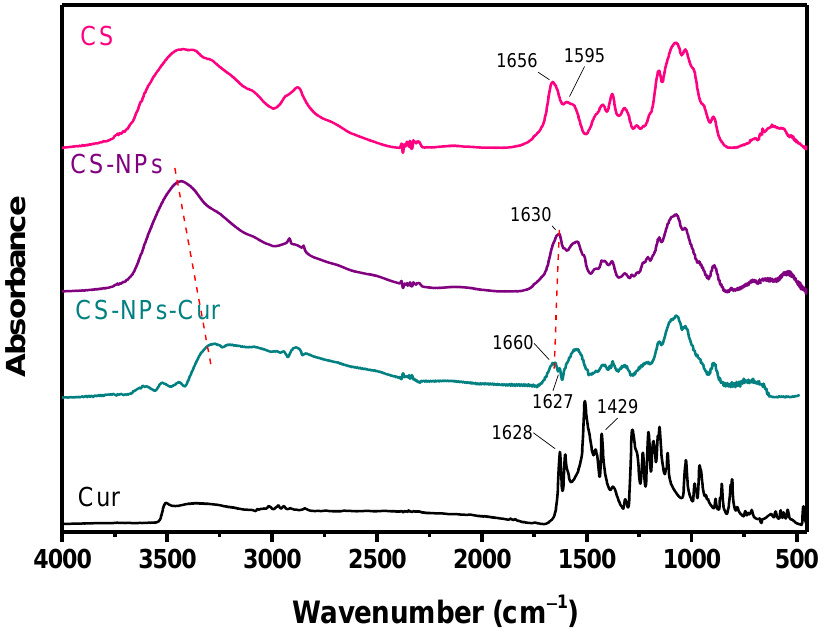
Figure 1. FTIR spectra of CS, CS-NPs, CS-Cur-NPs, and Cur.